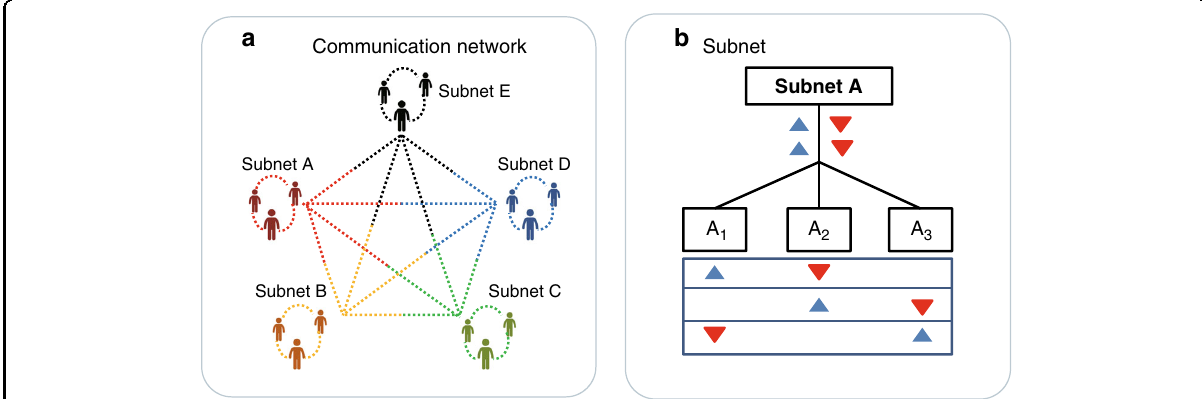
Fig. 1 Composition of a quantum network. a The quantum network is fully connected by fi ve subnets (A, B, C, D, and E are represented by red, orange, green, blue, and black, respectively). The dotted lines between the subnets (ten links with different colors) are the correlated time – energy photon pairs between the subnets. b Every subnet (such as subnet A) is equipped with a 1 × 3 BS and a delay controlling module, which splits a frequency-correlated entangled photon pair (red and blue signs) and sends them to three users